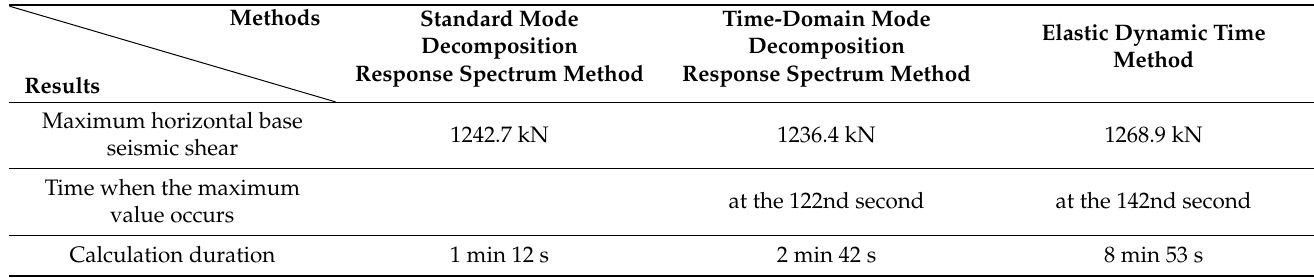
Table 1. Calculation and analysis of base shear force for a frame